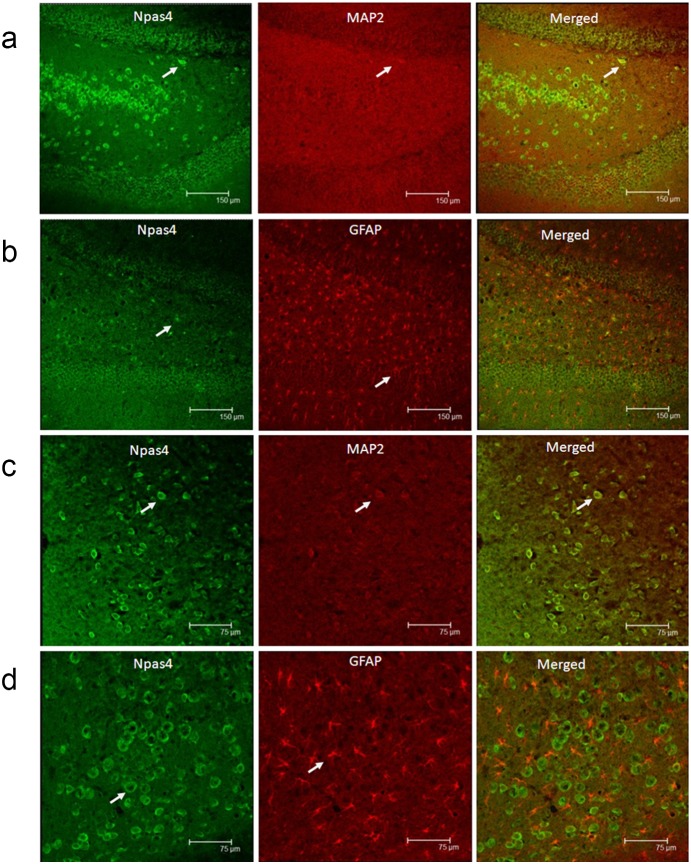
A confocal microscopic image of Npas4 in different rat brain tissues.Npas4 (green) and MAP2 (red) are co-expressed within neurons in the rat hippocampus and neocortex (a, c). Npas4 (green) and GFAP (red) are not co-expressed in the astrocytes in the hippocampus and cortex (b, d). Scale bar: (a, c) 150 µm, (b, d) 75 µm.